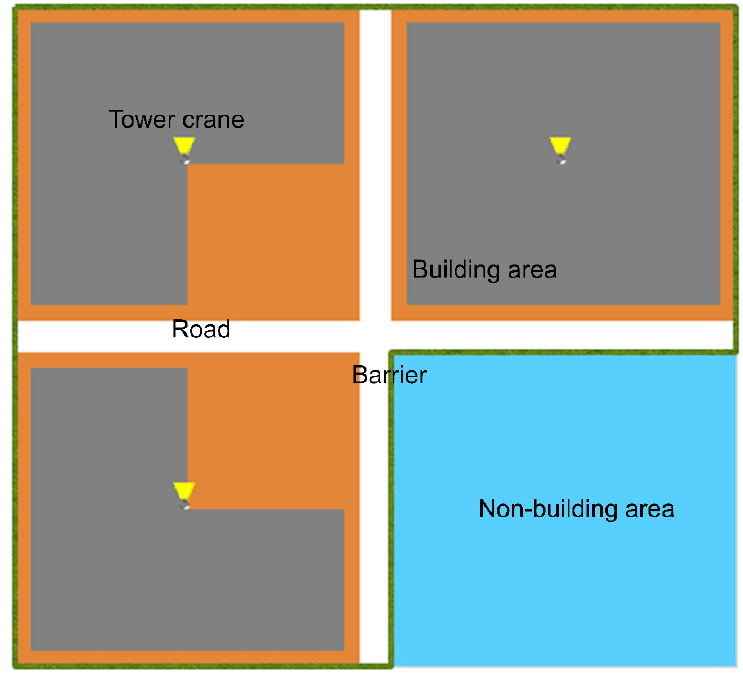
Figure 2. Virtual construction site.